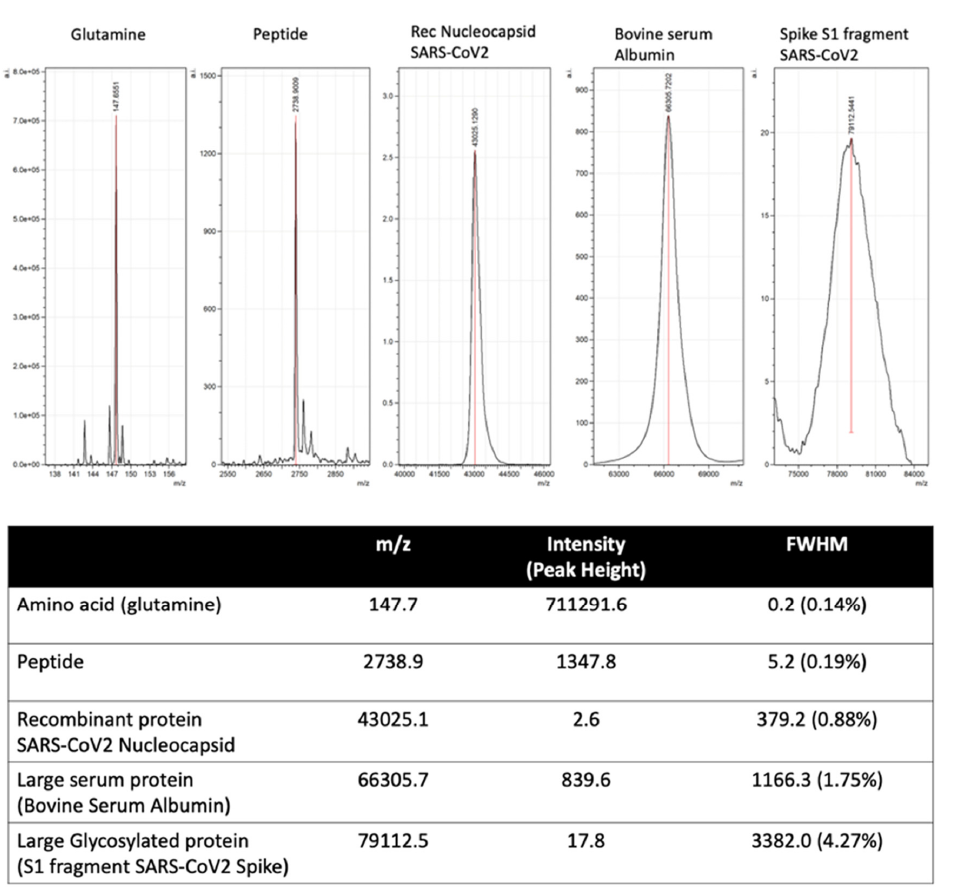
Figure 7. Illustration of mass spectral peak spreading due to increased complexity of combined isotopic composition and post-translational modification of large proteins.